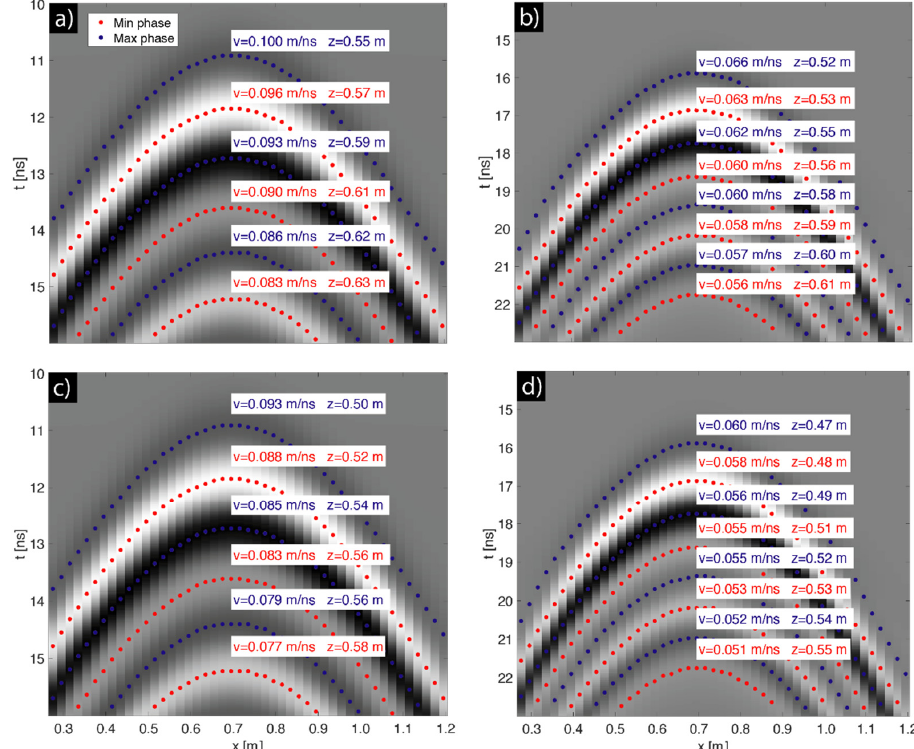
Figure 11. Resulting velocities and depths of the object when picking different phases. ( a , c ) For a material with theoretical velocity 0.095 m/ns, ( b , d ) for a material with theoretical velocity 0.06 m/ns. In both cases the object in 0.5 m depth had a radius of 10 cm. ( a , b ) use the simple hyperbola Equation (1), whereas ( c , d ) take into account the correct radius and antenna offset (B = 0.075 m) (Equation